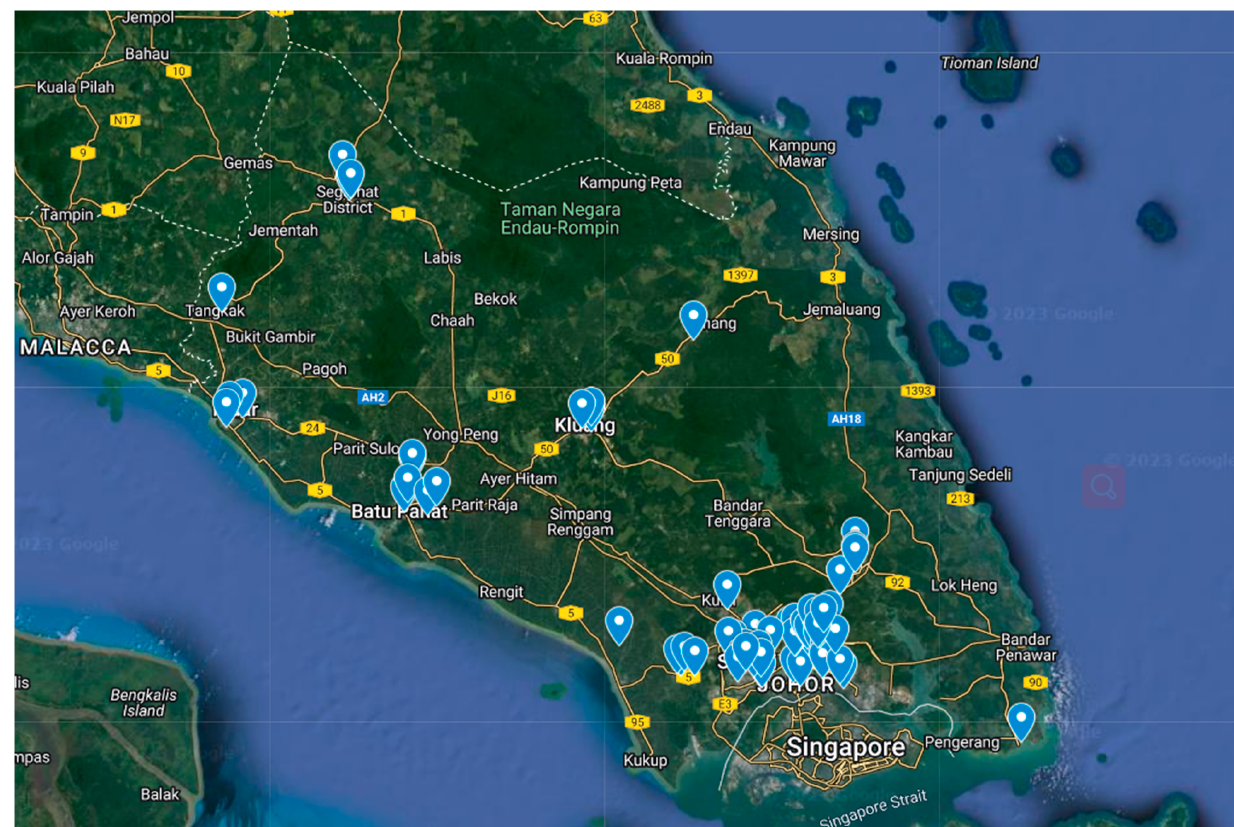
Figure 6. Gautama Buddha Distribution Map.